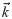
Spike-history dependencies of intermediate strength facilitate nonlinear decoding in simple models of neural processing.A: Schematic of a single-cell Generalized Linear Model (see Methods). The neuron’s sensitivity to the stimulus is determined by a radially symmetric difference-of-Gaussians spatial filter that has a monophasic timecourse (k→), and combines additively with the neuron’s sensitivity to its own past spiking, given by filter h→ (with strong refractoriness followed by weak facilitation). Importantly, h→ shapes spike-history dependencies in the resulting spike trains. A nonlinear function f(⋅) (here, threshold-linear) of the combined sensitivities gives the neuron’s instantaneous firing rate that can be used to generate individual spike train instances. Shapes, as well as the temporal and spatial scales of the filters, were realistic for our data. B: Example rasters (50 repeats) generated with the encoding model for a given intensity trace and different magnitudes (α) of spiking history filter h→. The rasters are matched in PSTH (bottom) but differ in temporal noise correlations. C: Average spike count variance-to-mean ratio, F, (± SD) of the model as a function of α in fluctuating and constant epochs. D: Decoding error as a function of α. Decoders are trained for each separate α and tested on withheld stimuli; shade = SD over 10 spike train realizations.